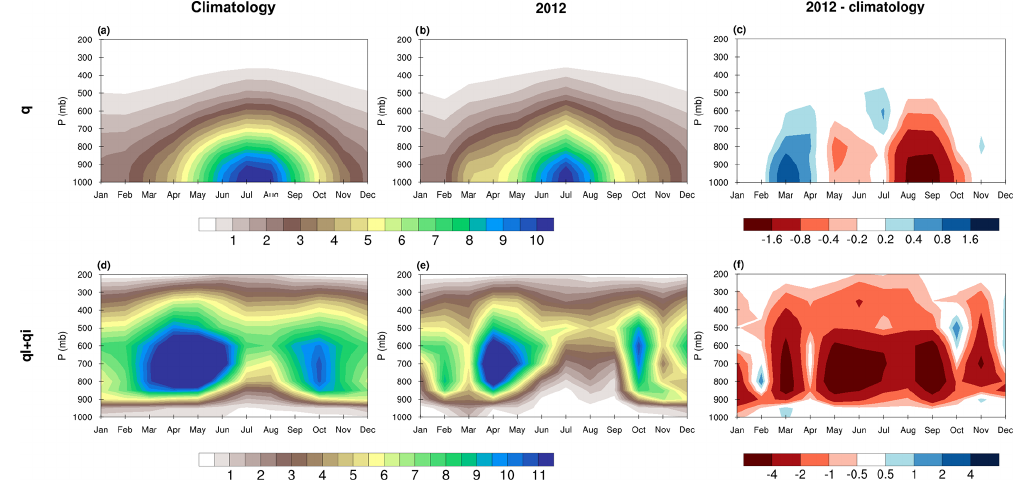
Figure 4. Same as Fig. 3 but for the NGP (39–48 ◦ N and 95–105 ◦ W) in 2012.